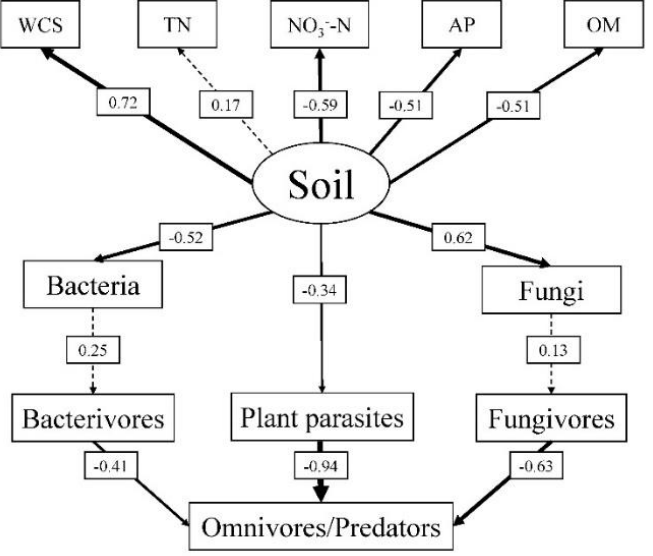
Figure 7. Feeding relationships in the soil food network under different cover crop patterns uncovered by SEM (X 2 = 43.595, d.f. = 36, p = 0.180, GFI = 0.831, CFI = 0.874, RMSEA = 0.067). Solid lines represent significant correlations ( p < 0.05) and dotted lines indicate nonsignificant correlations. WCS, water content of soil; TN, total nitrogen; AP, available phosphorus; OM, organic matter; NO 3 − -N, nitrate.